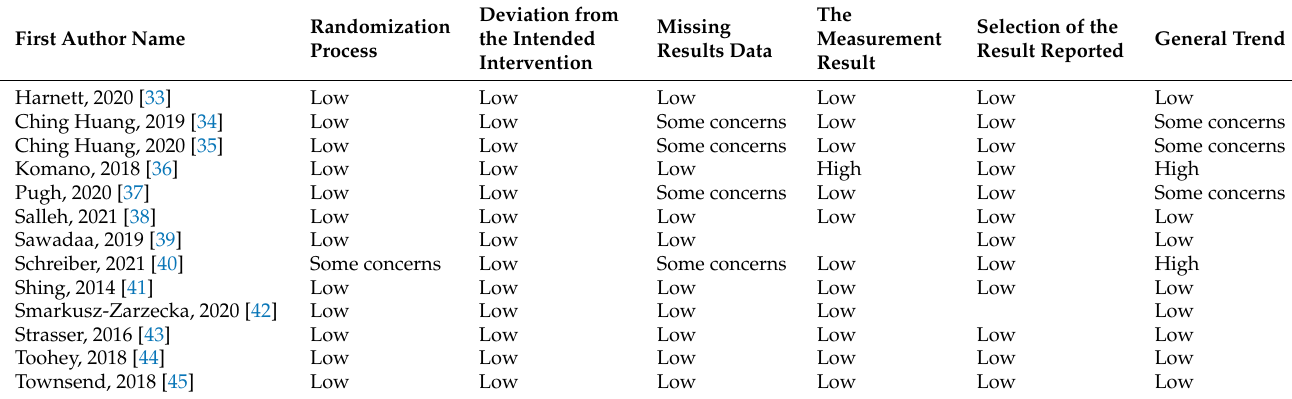
Table 3. Methodological quality of the studies using the tool RoB